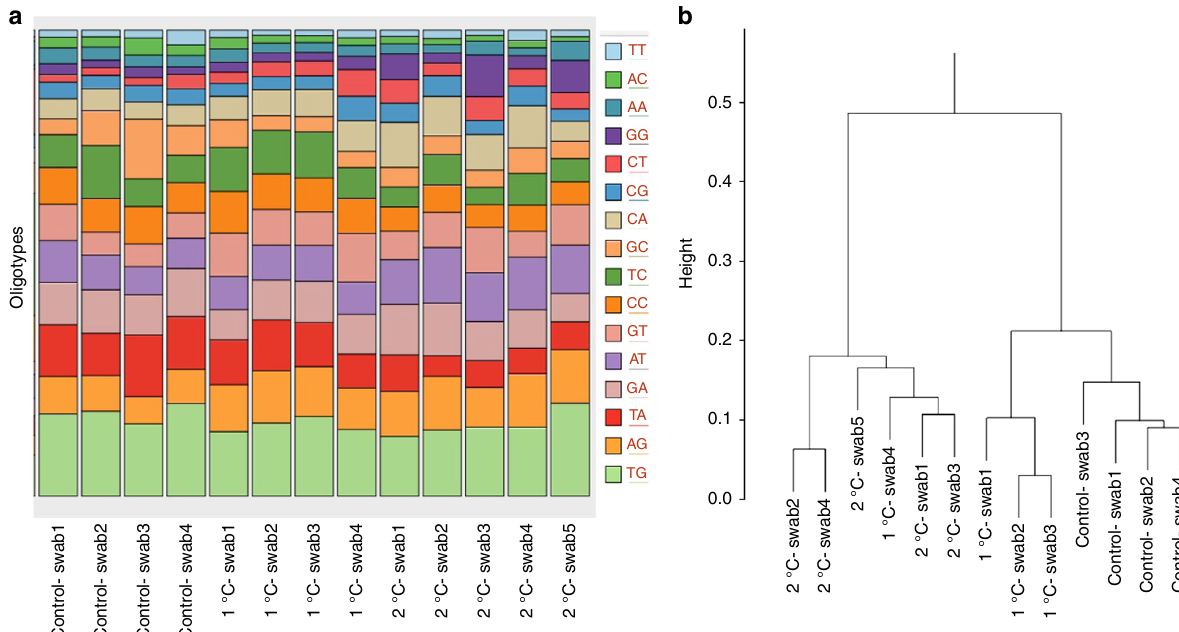
Fig. 3 Oligotype analyses identifying the most abundant bio fi lm. a Proportions of the 16 abundant oligotypes in the bio fi lm samples for the different treatments (control, + 1 and + 2). Source data are provided as a Source Data fi le. b Bray – Curtis distance measures for oligotypes from bio fi lm communities from panels (controls, + 1 and +